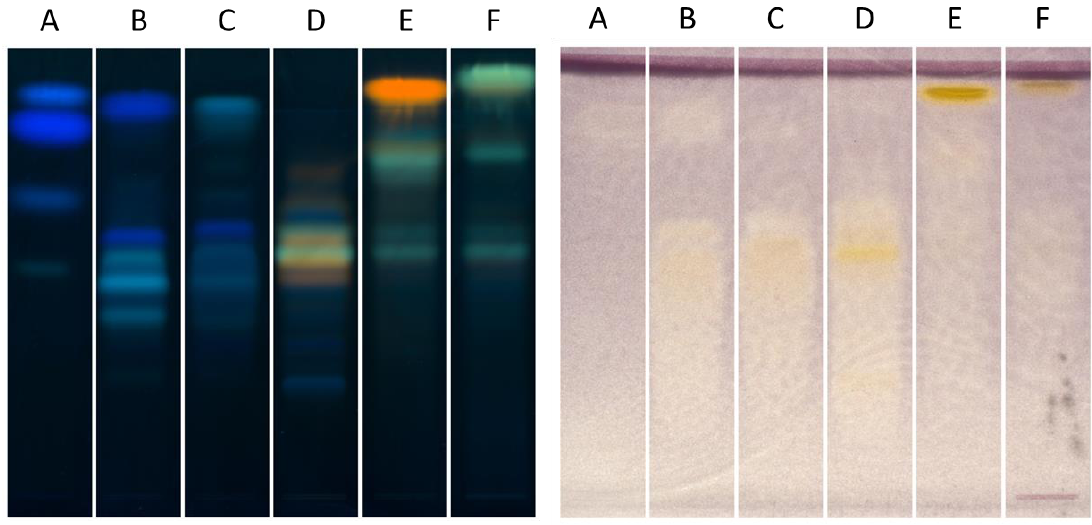
Figure 2. HPTLC analyses with NP-PEG derivatization ( left ) and XO bioautography ( right ) of fractions A to F .